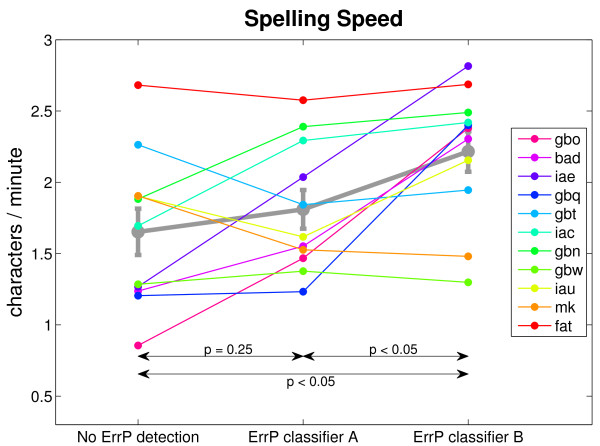
Spelling Speed. Spelling Speed in the three conditions: without ErrP detection (left), with ErrP classifier A (middle) and with ErrP classifier B (right). The gray error bars give the mean speed and standard error for each condition. The double arrows indicate the three paired-samples t-tests with the respective p values.